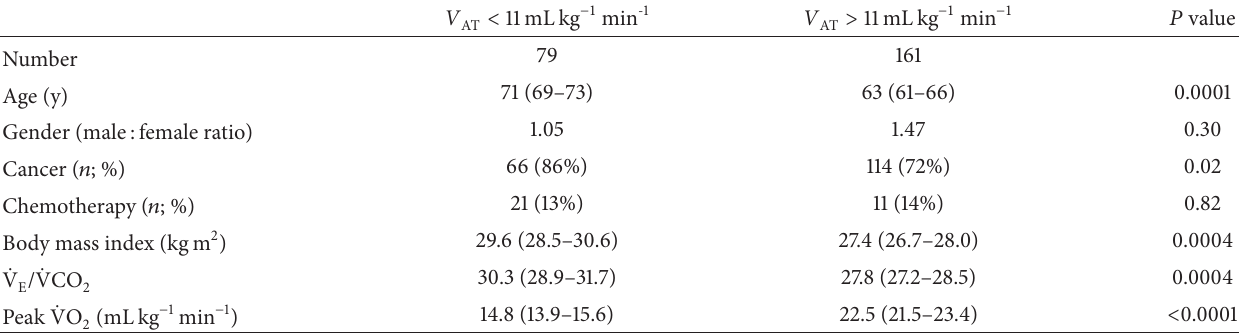
Table 1: CPET demographics in colorectal surgery cohort, stratified according to the prognostically relevant anaerobic threshold < 11mLkg − 1 min − 1 and > 11mL kg − 1 min − 1 .